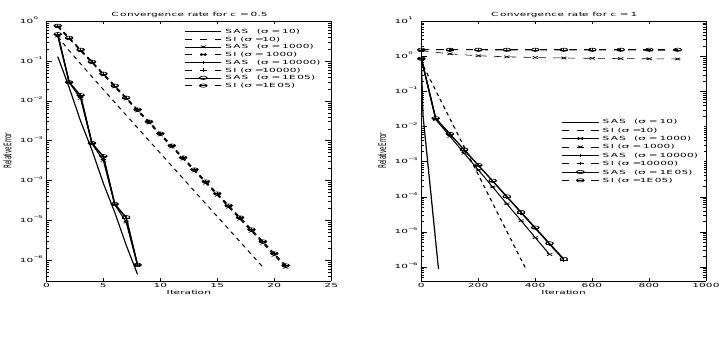
Convergence rate for c = 0.5